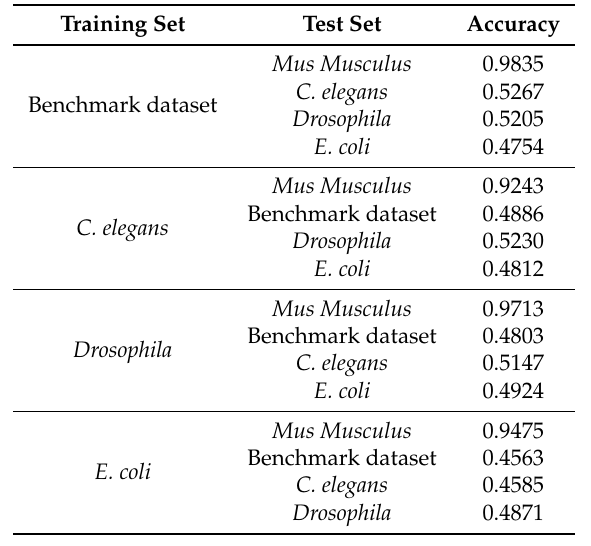
Table 11. Performances on the cross-species